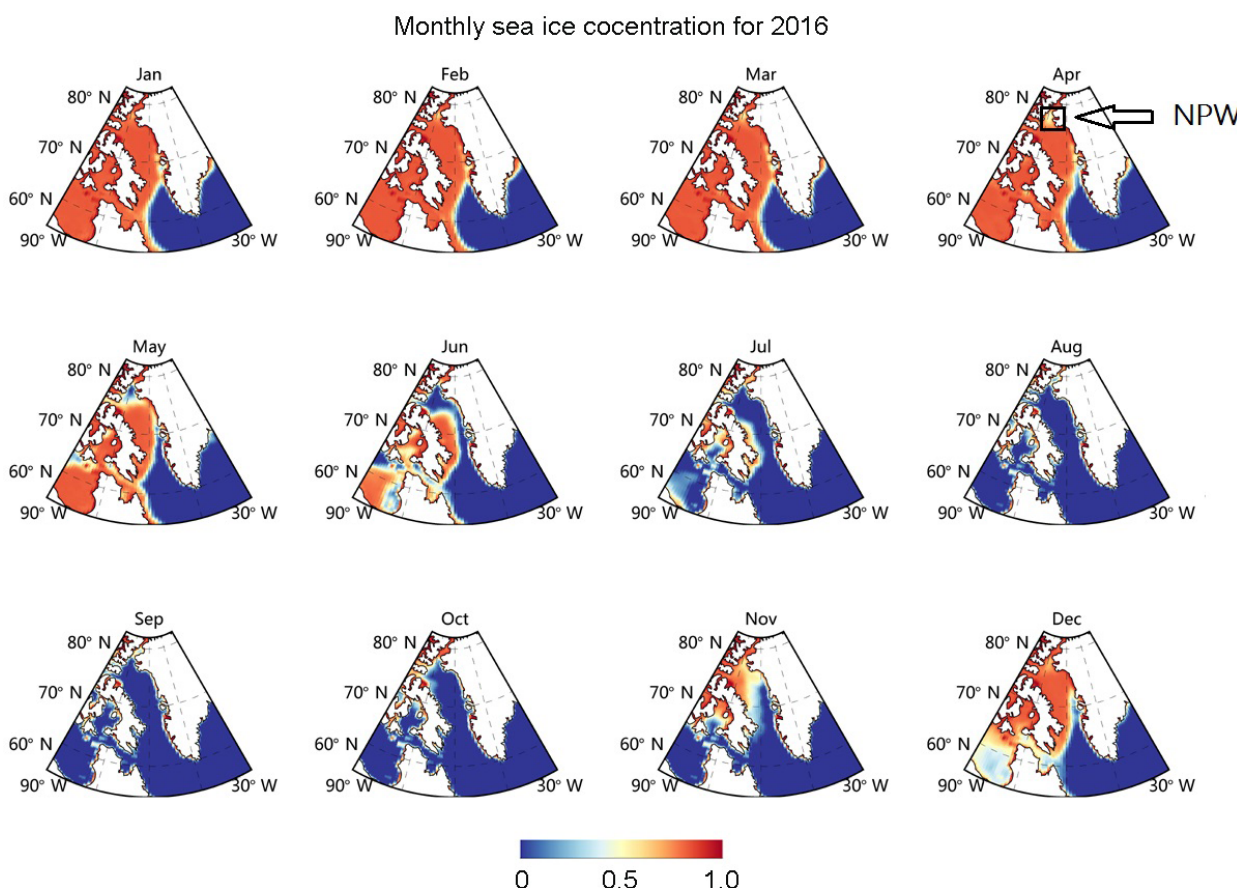
Figure 7. Spatial variations of mean sea ice concentration fields for the calendar months in 2016. In the panel for April, NOW is outlined.